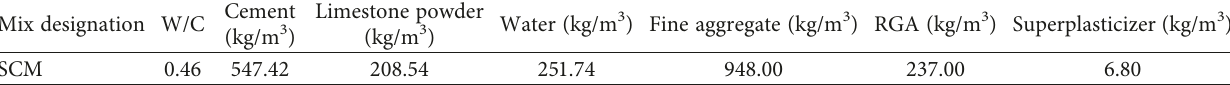
Table 3: Mix design proportioning of SCM mix for the production of translucent concrete.